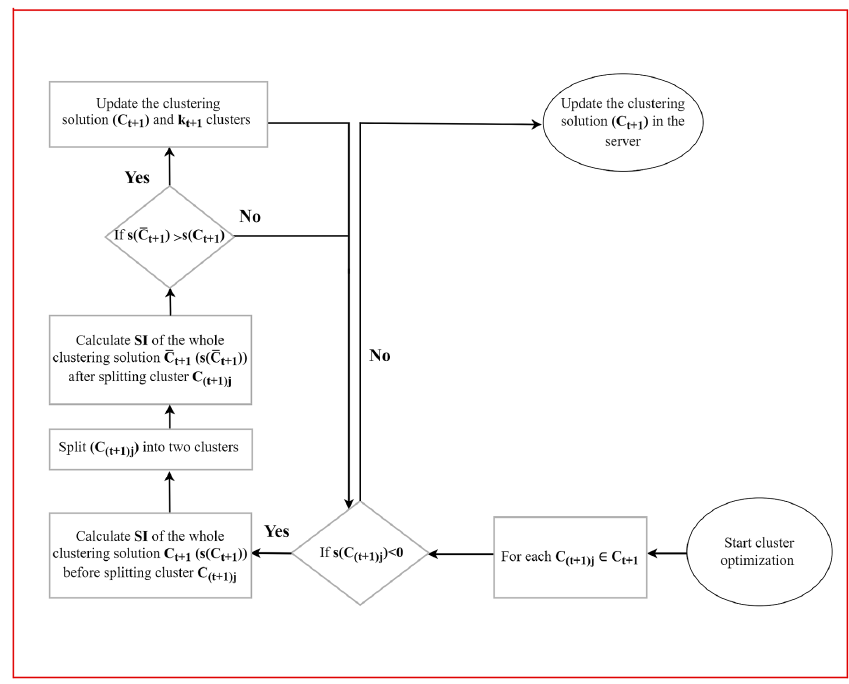
Figure 3. Flowchart depicting Cluster optimization